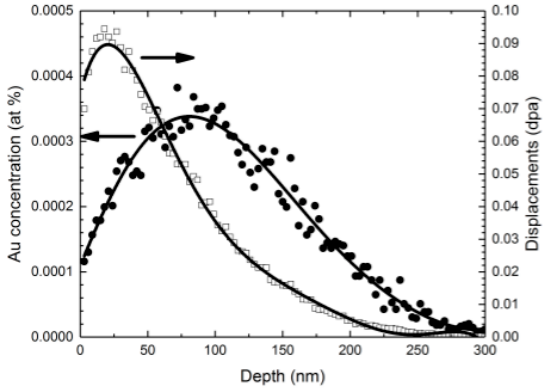
Figure 3. Stopping and Range of Ions in Matter (SRIM) predicted Au concentration (at %) and damage dose (dpa) for 2.8 MeV Au 4+ into a Au foil for a fluence of 3.6 × 10 12 ions/cm 2 . Filled circles indicate the Au concentration profile, and empty squares indicate the Au displacement damage profile. Lines of fit are only meant to guide the eye.